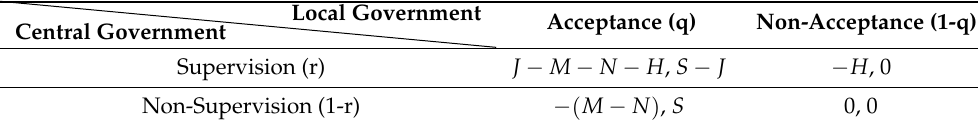
Table 3. The game matrix of the central government and the local government in collusion. Local Government Acceptance (q) Non-Acceptance (1-q) Central Government Supervision (r) J − M − N − H , S − J − H , 0 Non-Supervision (1-r) − ( M − N ) , S 0,